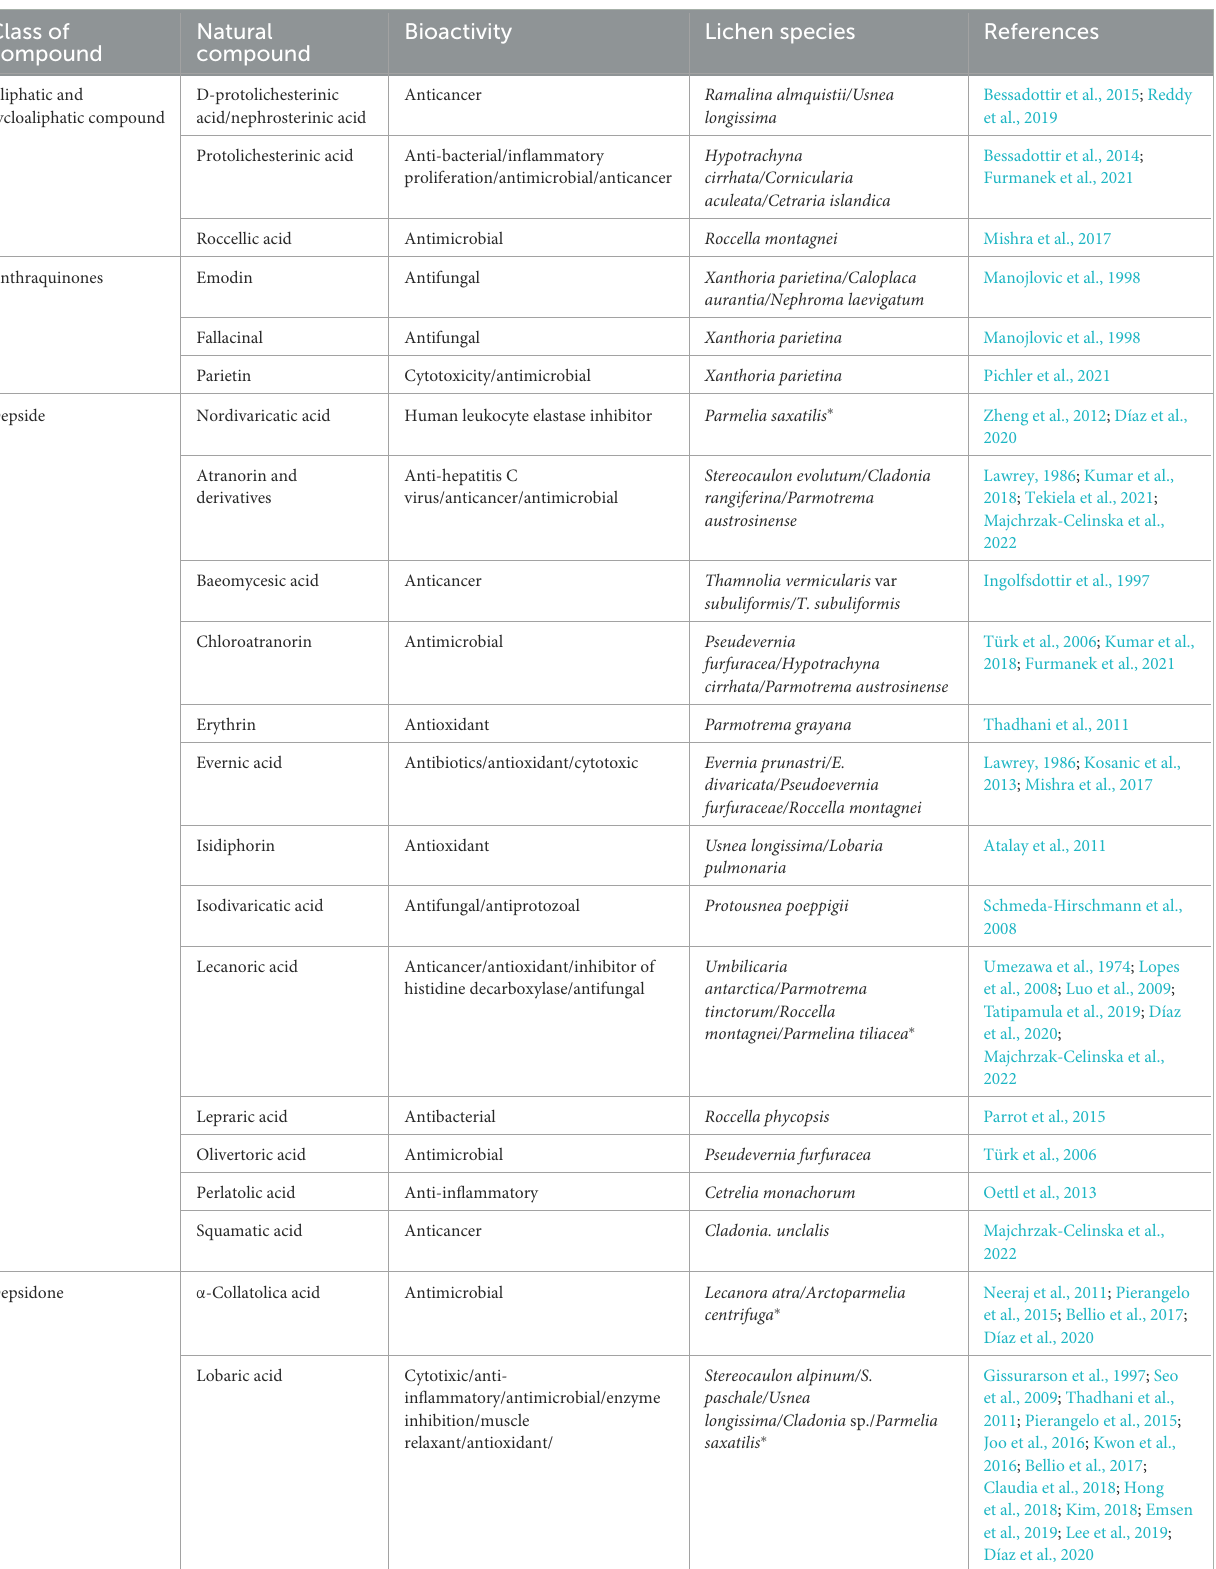
TABLE 1 The known lichen bioactive natural products from a thallus or LFF